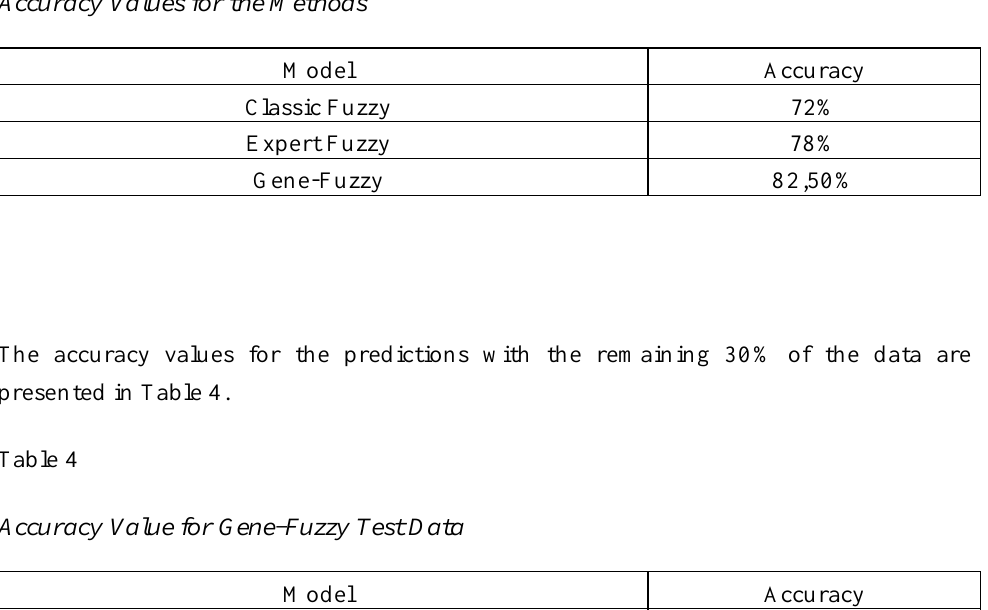
Accuracy Values for the Methods